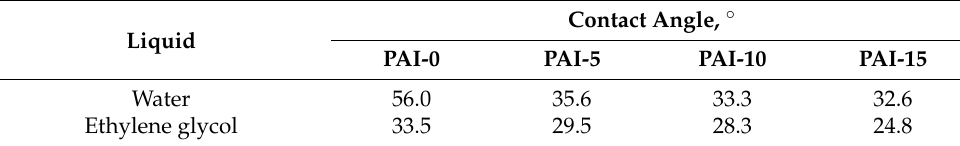
Table 4. Contact angles of the membranes at 25 ◦